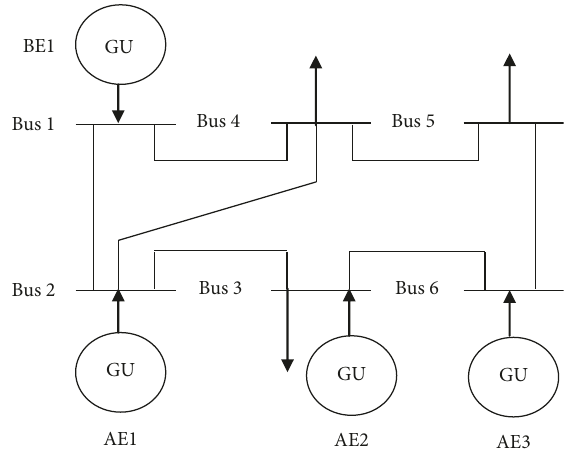
Figure 2: The modified 6-bus IEEE transmission grid